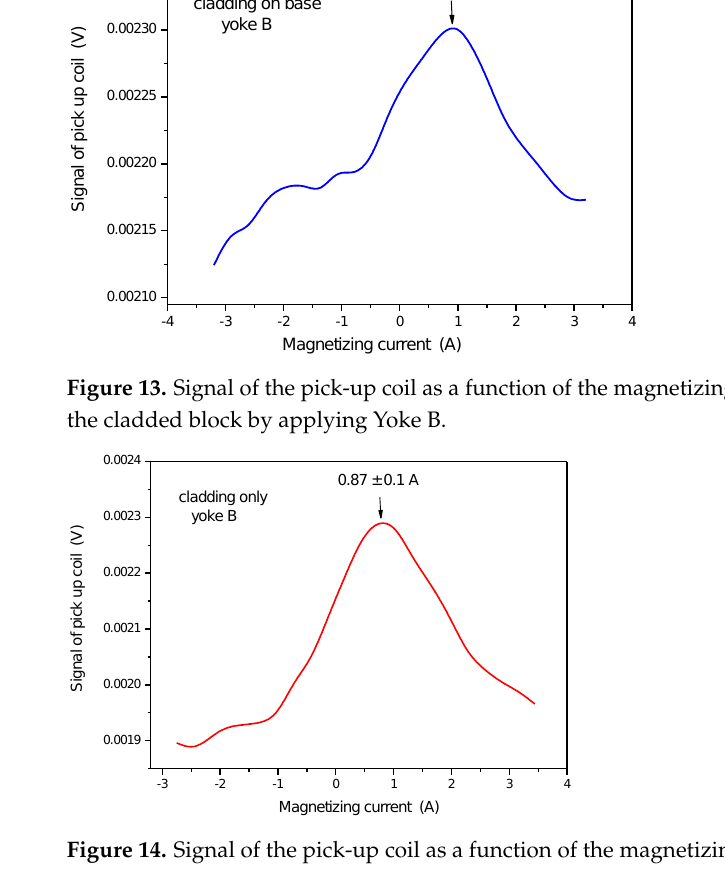
Figure 14. Signal of the pick-up coil as a function of the magnetizing current, measured on the pure cladding by applying Yoke